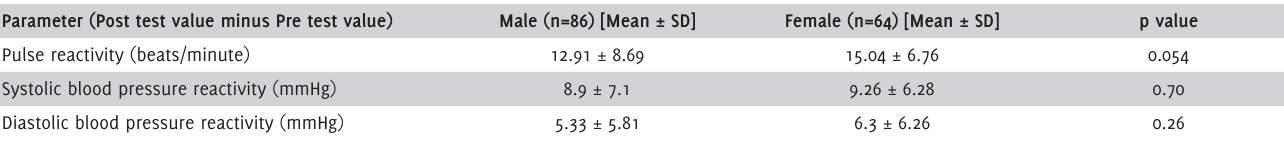
p<0.05-statistically